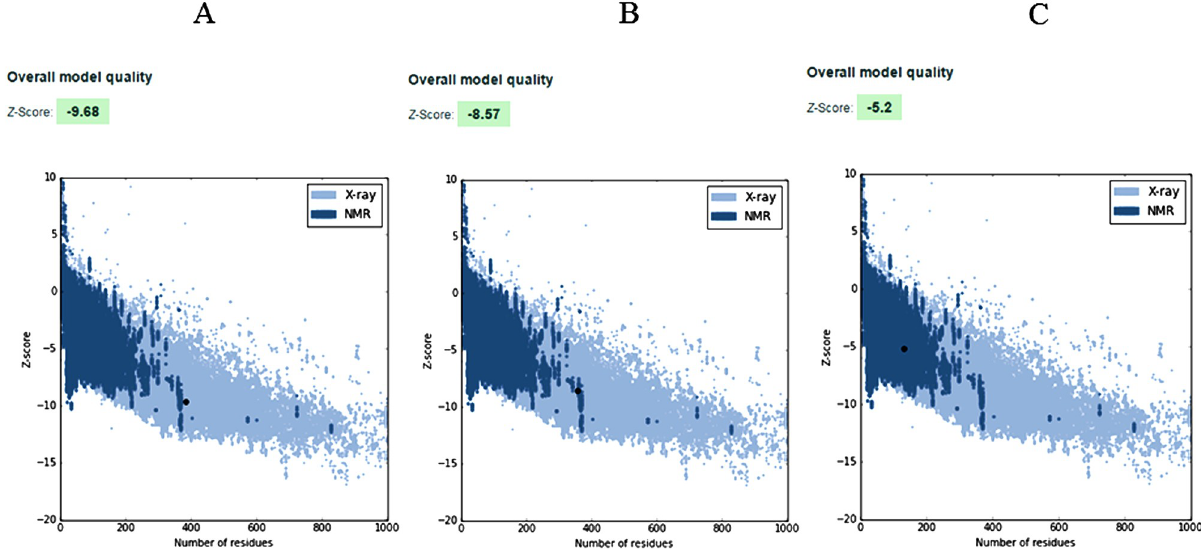
Fig 12. ProSA analysis for nrtA (A), nrtC (B), nrtD (C) proteins. Z-scores of the protein chains in PDB were determined by X-ray crystallography (light blue) and NMR spectroscopy (dark blue). The proSA web results indicated that protein structures had characteristic features of their native structures. The Z-score for all the three target proteins was highlighted as a large